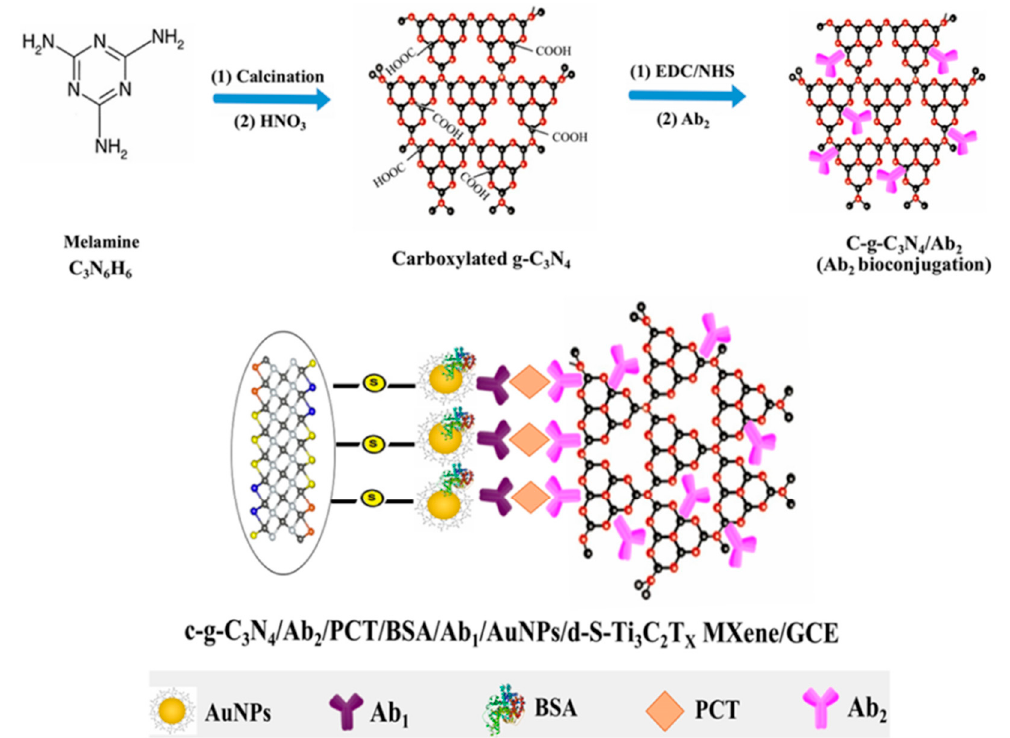
Figure 10. Preparation of carboxylated c-g-C 3 N 4 and Ab 2 bioconjugate ( up ) and sandwich-type immunosensor ( down ). Reproduced from [121] with permission.